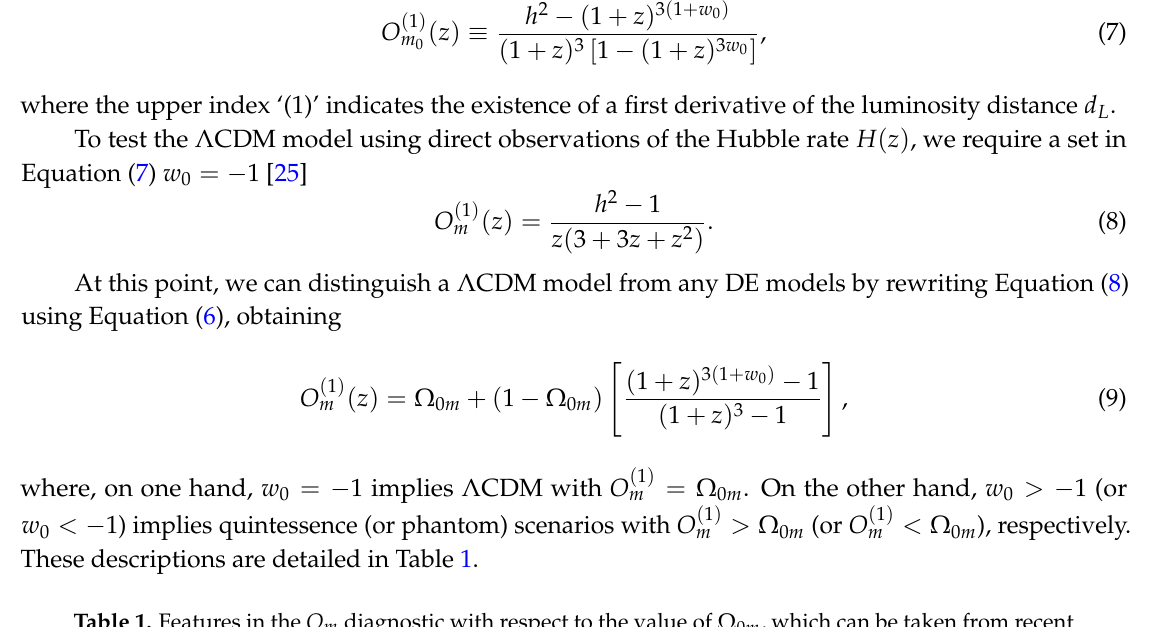
Table 1. Features in the O m diagnostic with respect to the value of Ω 0 m , which can be taken from recent Planck results [46] and a constant EoS w = w 0 .